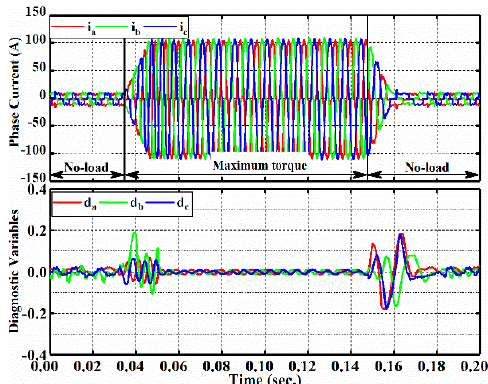
Figure 8. Experimental results about waveforms of phase currents and diagnostic variables under the load variations at rated speed of 360